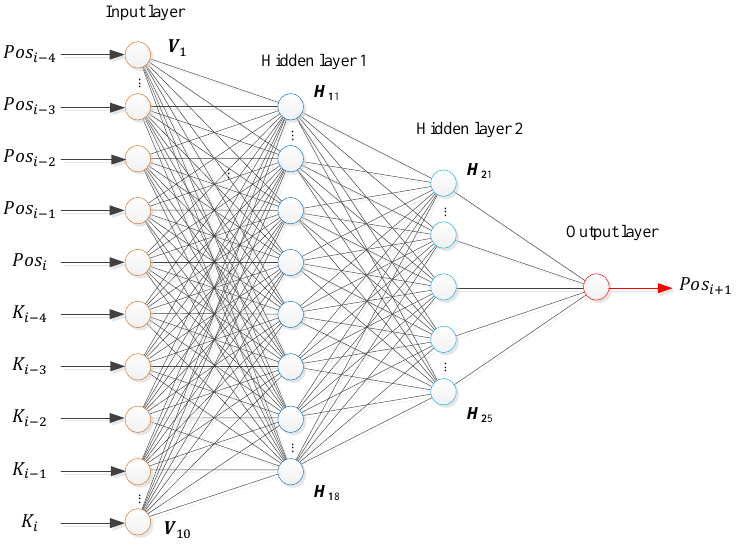
Figure 11. Structure of the BP neural network.